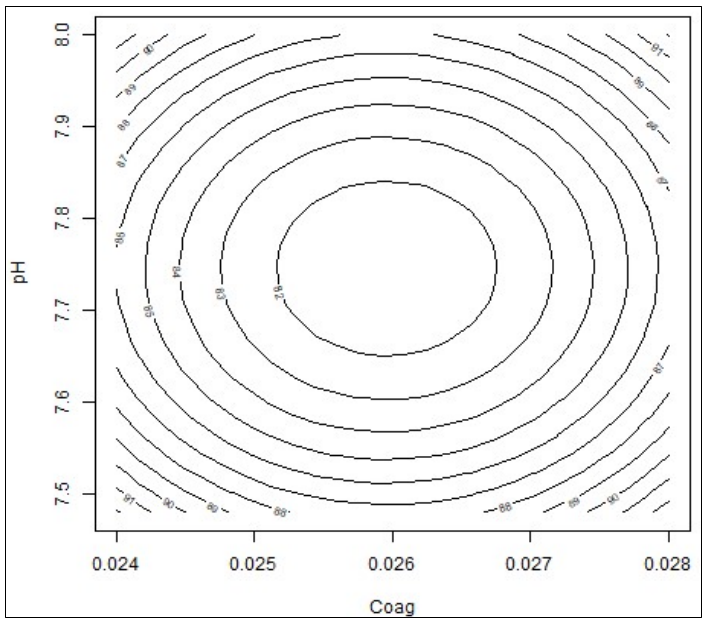
Figure 5. Effect of pH and coagulant concentration on COD removal. Coag: Coagulant, pH: poten- tial hydrogen.